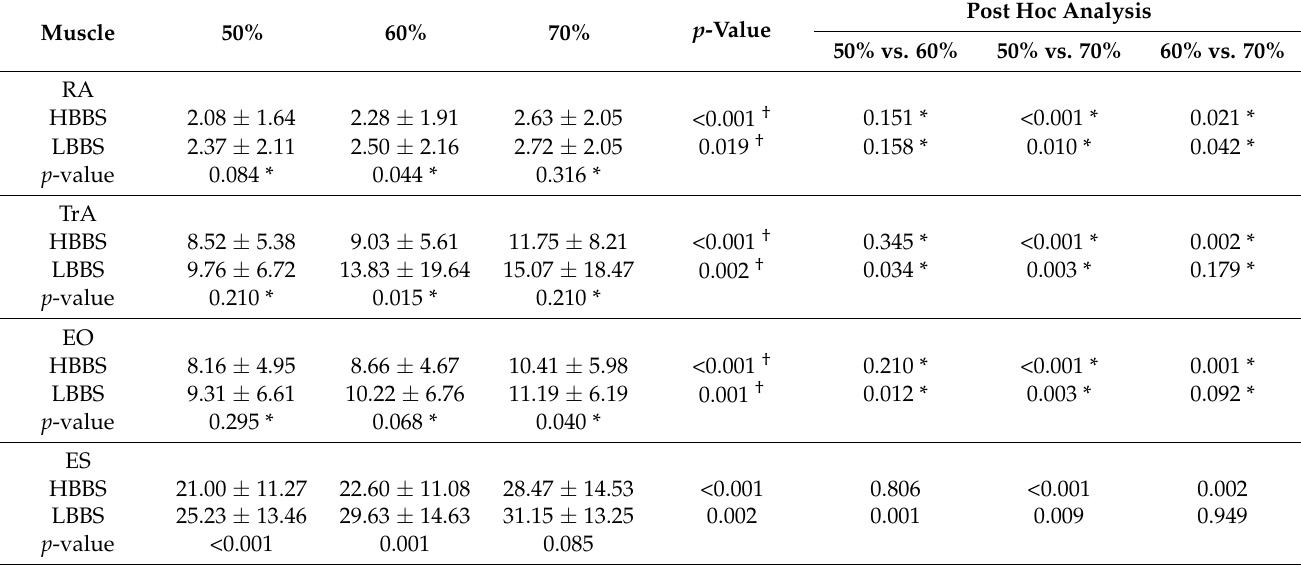
Table 4. Comparison of the muscle activity of the trunk during the eccentric